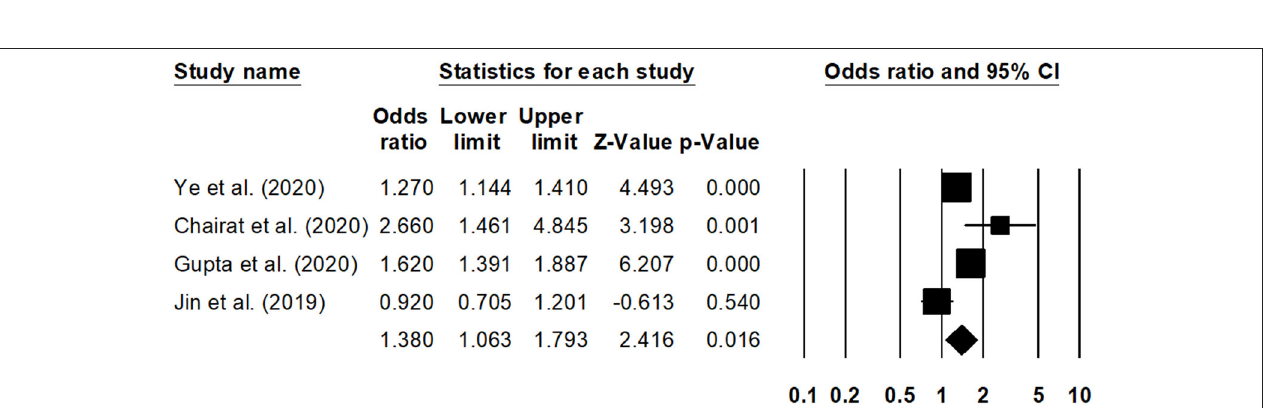
FIGURE 7 | Forest plot for studies evaluating the overall 1-year overall mortality outcome for HF patients with preserved ejection fraction. The adjusted odds ratios are presented as black boxes, whereas 95% confidence intervals are presented as whiskers. A negative odds ratio represents a reduction in the risk of mortality in heart failure patients with anemia, whereas the positive odds ratio represents an increase in the risk of mortality in heart failure patients with anemia.